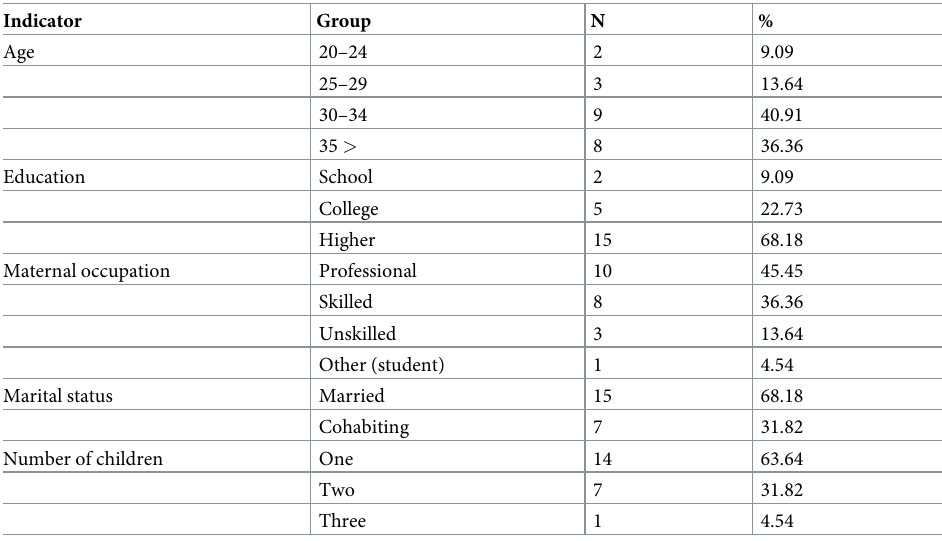
Table 2. Sample distribution by sociodemographic